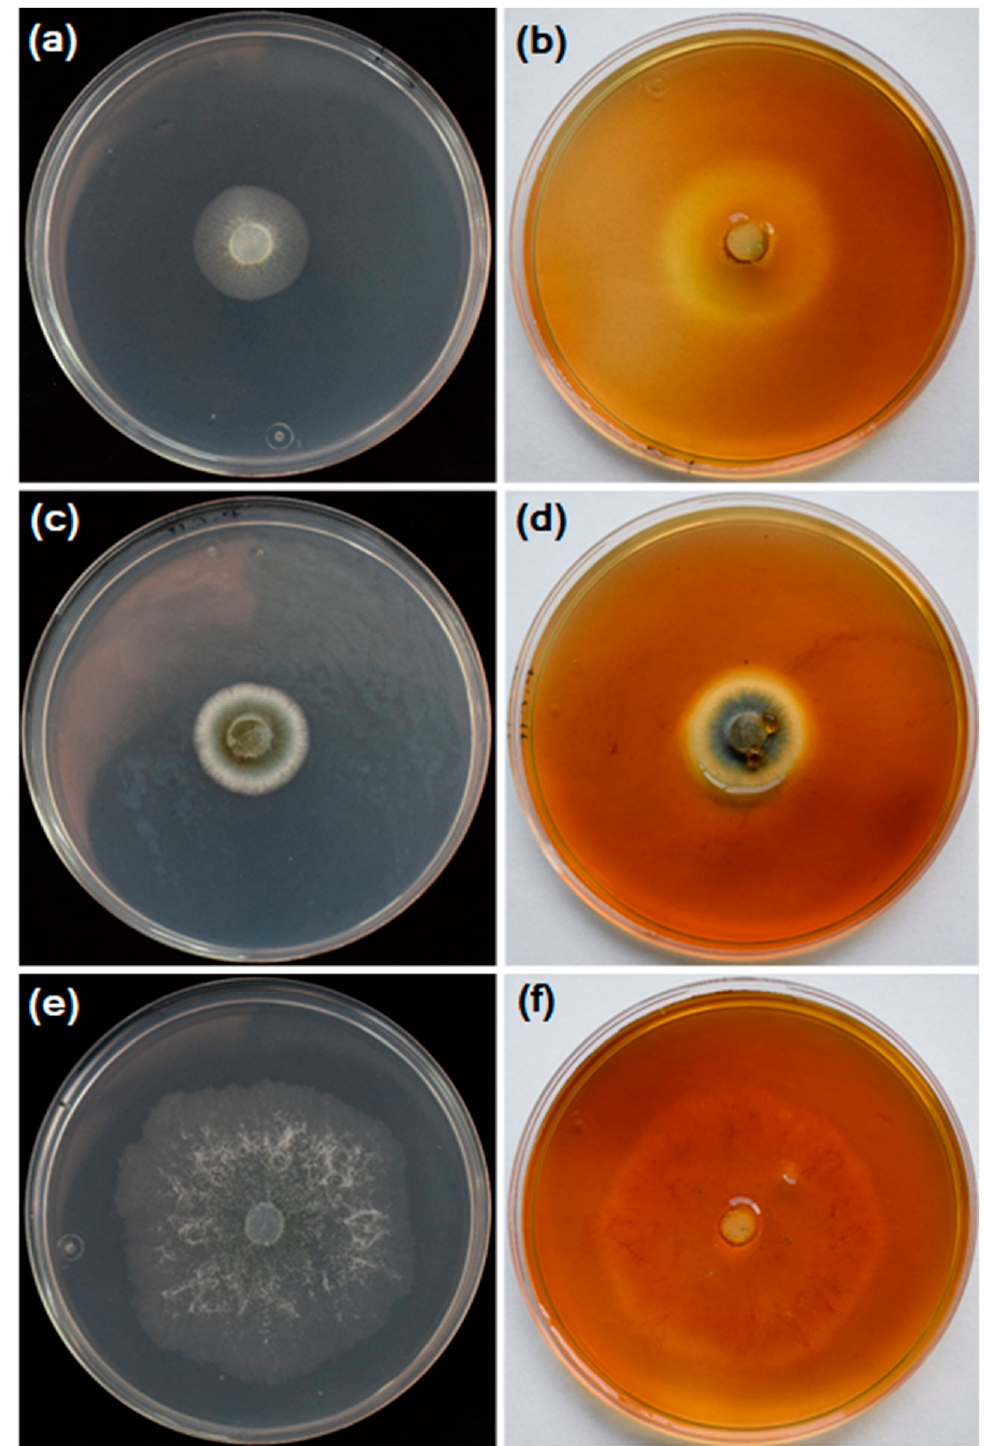
Figure 4. Cellulose degradation ability shown by several fungal isolates obtained from degraded wood by the subterranean termites Reticulitermes grassei . Fungal colonies of ( a , b ) Penicillium chryso- genum isolate MZC-0 (positive control), ( c , d ) P. citrinum isolate MZC-21, and ( e , f ) Trichoderma longi- brachiatum grown on carboxymethylcellulose at 25 ± 2 ◦ C in the dark for 96 and 36 h for Penicillium isolates and T. longibrachiatum , respectively; ( a , c , e ) before and ( b , d , f ) at 5 min after flooding with Gram’s iodine